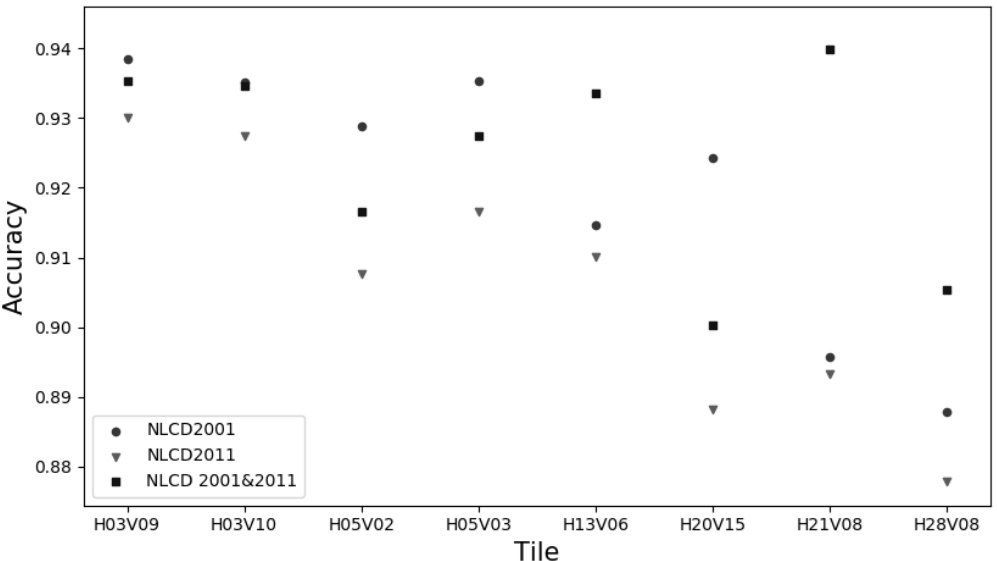
Figure 6. The average accuracy distribution of 10 iterations at 8 tiles using training data from National Land Cover Database (NLCD) 2001 and 2011, and 2001&2011. The standard deviation of accuracy across 10 iterations was less than 0.001 for all tests.